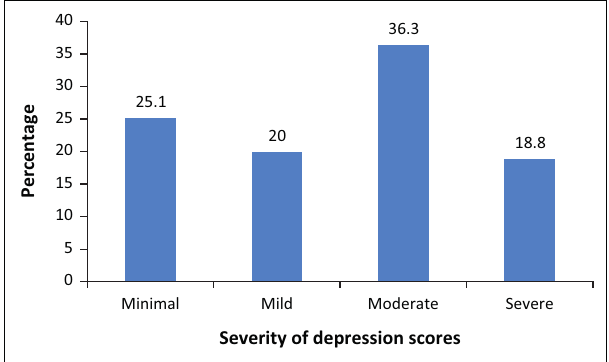
FIGURE 4: Total Beck Depression Inventory scores ( N = 80).